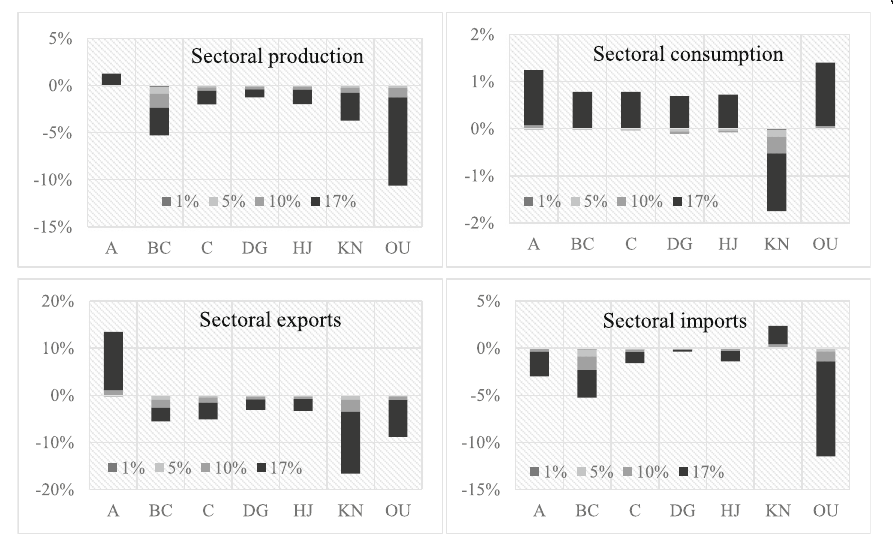
Fig. 13 Simulated sectoral effects of combination of a subsidy for benefits provided by agriculture and a tax on use of nitrogen fertilizers (product of chemical industry) in agriculture. (Source: authors calculations based on CGE model simulations